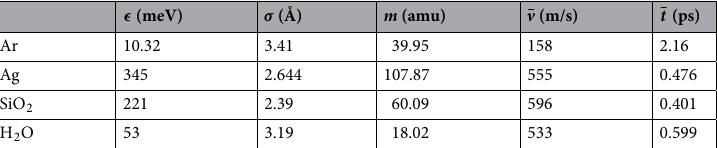
Table 1. LJ parameters, ǫ and σ , and mass, m , for four materials: Ar 37–39 , Ag 39–41 , silica 42 and water 42 . LJ units √ √ ǫ/ m and time ¯ t = σ m /ǫ for velocity, ¯ v =